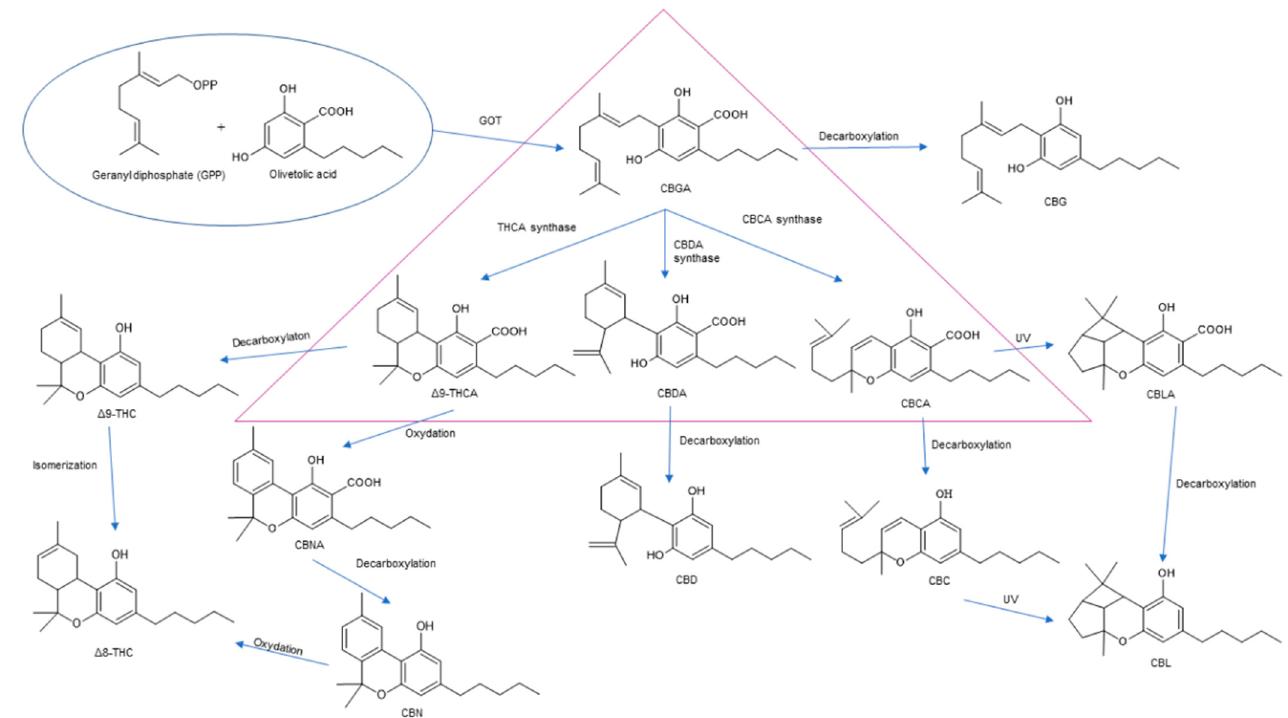
Figure 2. Biosynthesis pathways of selected cannabinoids [13,17,33,39]. The best-known cannabinoids that occur in Cannabis sativa L. are ∆ 9-THC and CBD. The global interest in CBD is growing due to its demonstrated analgesic, anti-inflammatory, and anxiolytic properties [1,39–41]. The chemical structure of CBD was determined by Mechoulam and Shvo in 1963 [42], with ∆ 9-THC being an isomer of this compound. The properties of selected neutral cannabinoids are listed in Table 2.